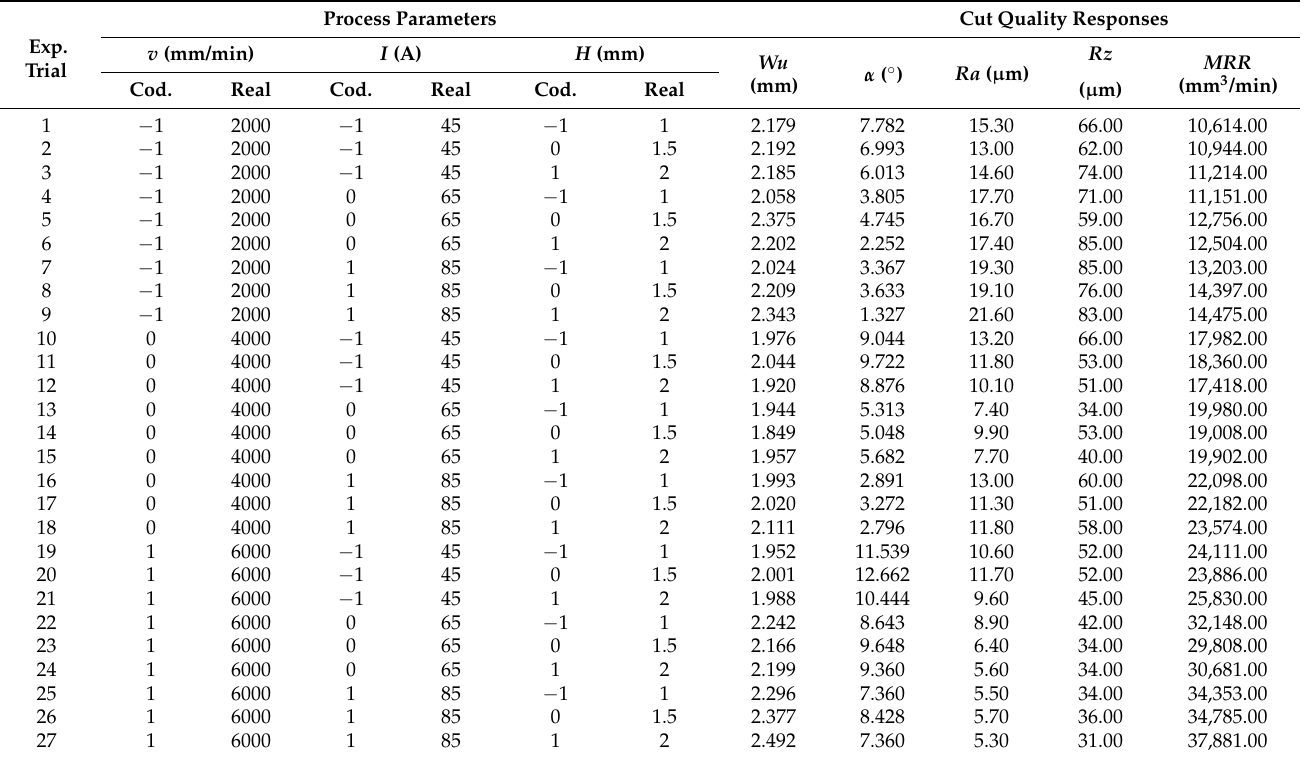
Table 5. Experimental plan and cut quality responses